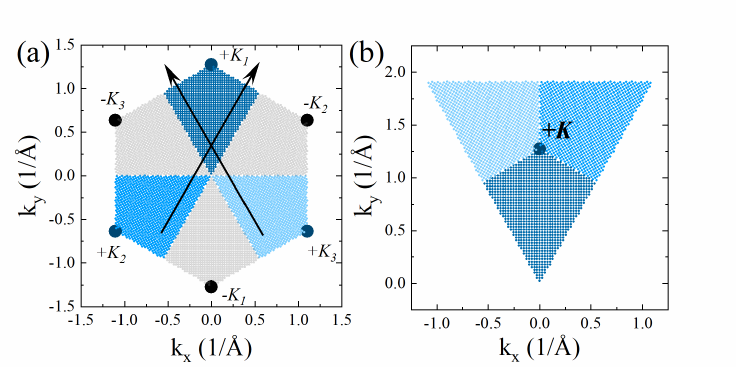
Figure 7. ( a ) Choice of + K valley on the whole BZ. ( b ) Construction of the valley around a single K